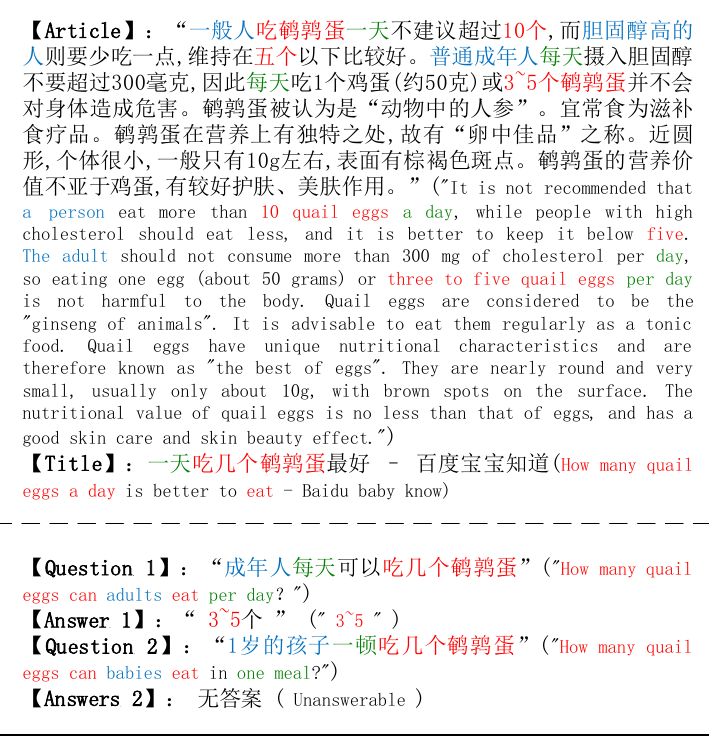
Figure 1. An example of the DuReader-checklist dataset. The same color in the article and the questions indicate that the corresponding content has relevant information; question 1 can find the corresponding answer fragment in the text, and question 2 has a similar correspondence in the text but is not the correct